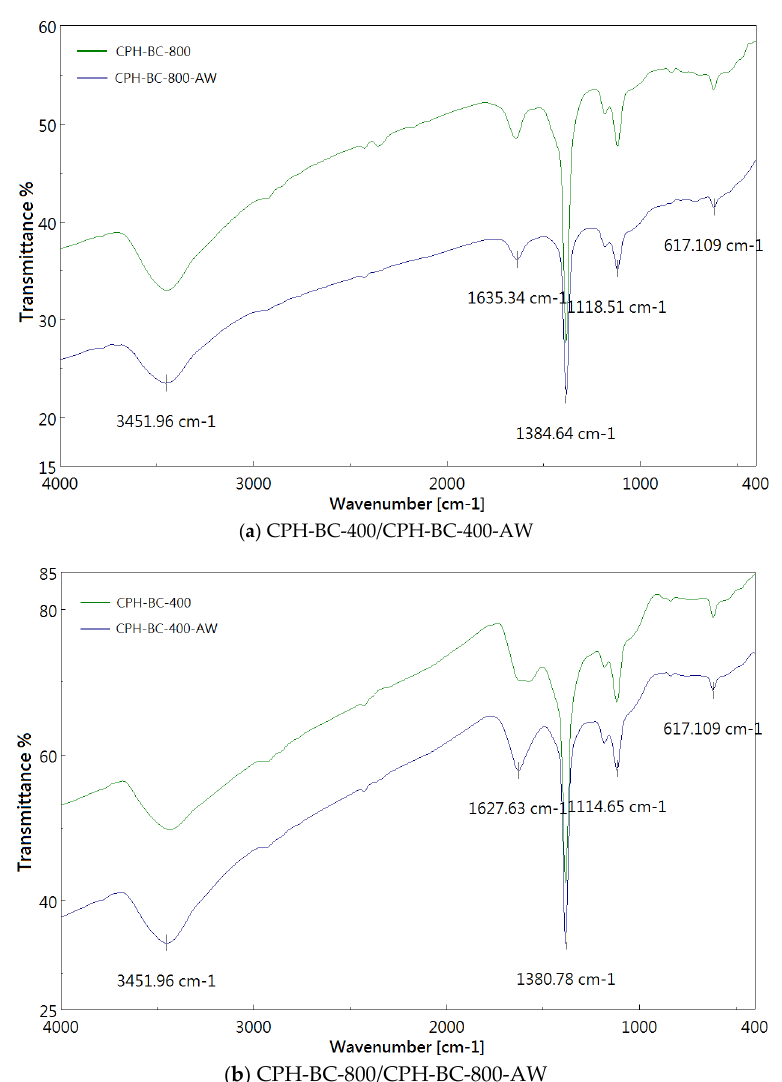
Figure 6. Fourier Transform infrared spectroscopy (FTIR) spectra of ( a ) CPH-BC-400/CPH-BC-400-AW, ( b ) CPH-BC-800/CPH-BC-800-AW. Table 2. FTIR spectra of CPH-BC-400/800 products and their corresponding assignments for the primary absorption peaks (cf. Figure 7).